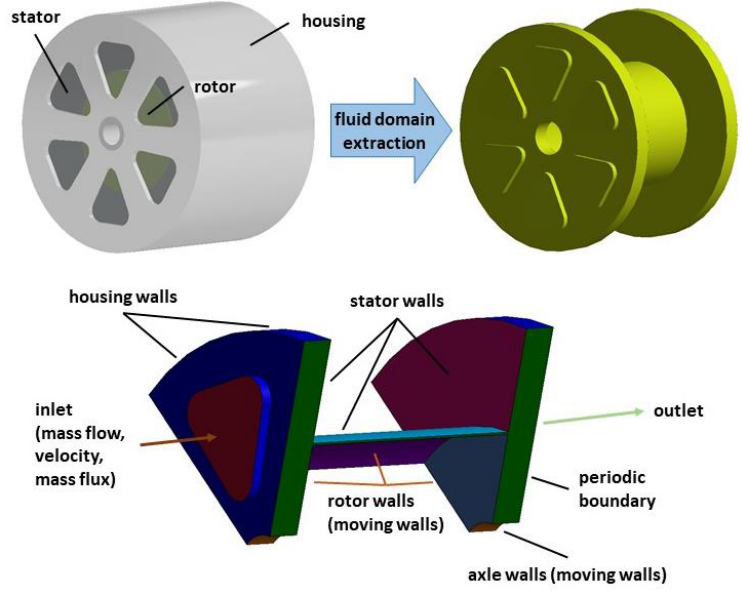
Figure 4. An example of an EM geometry ( top left ) from which the air gap and its surrounding volume are extracted ( top right ) to define the computational domain as well as its apparent boundary conditions ( bottom ).